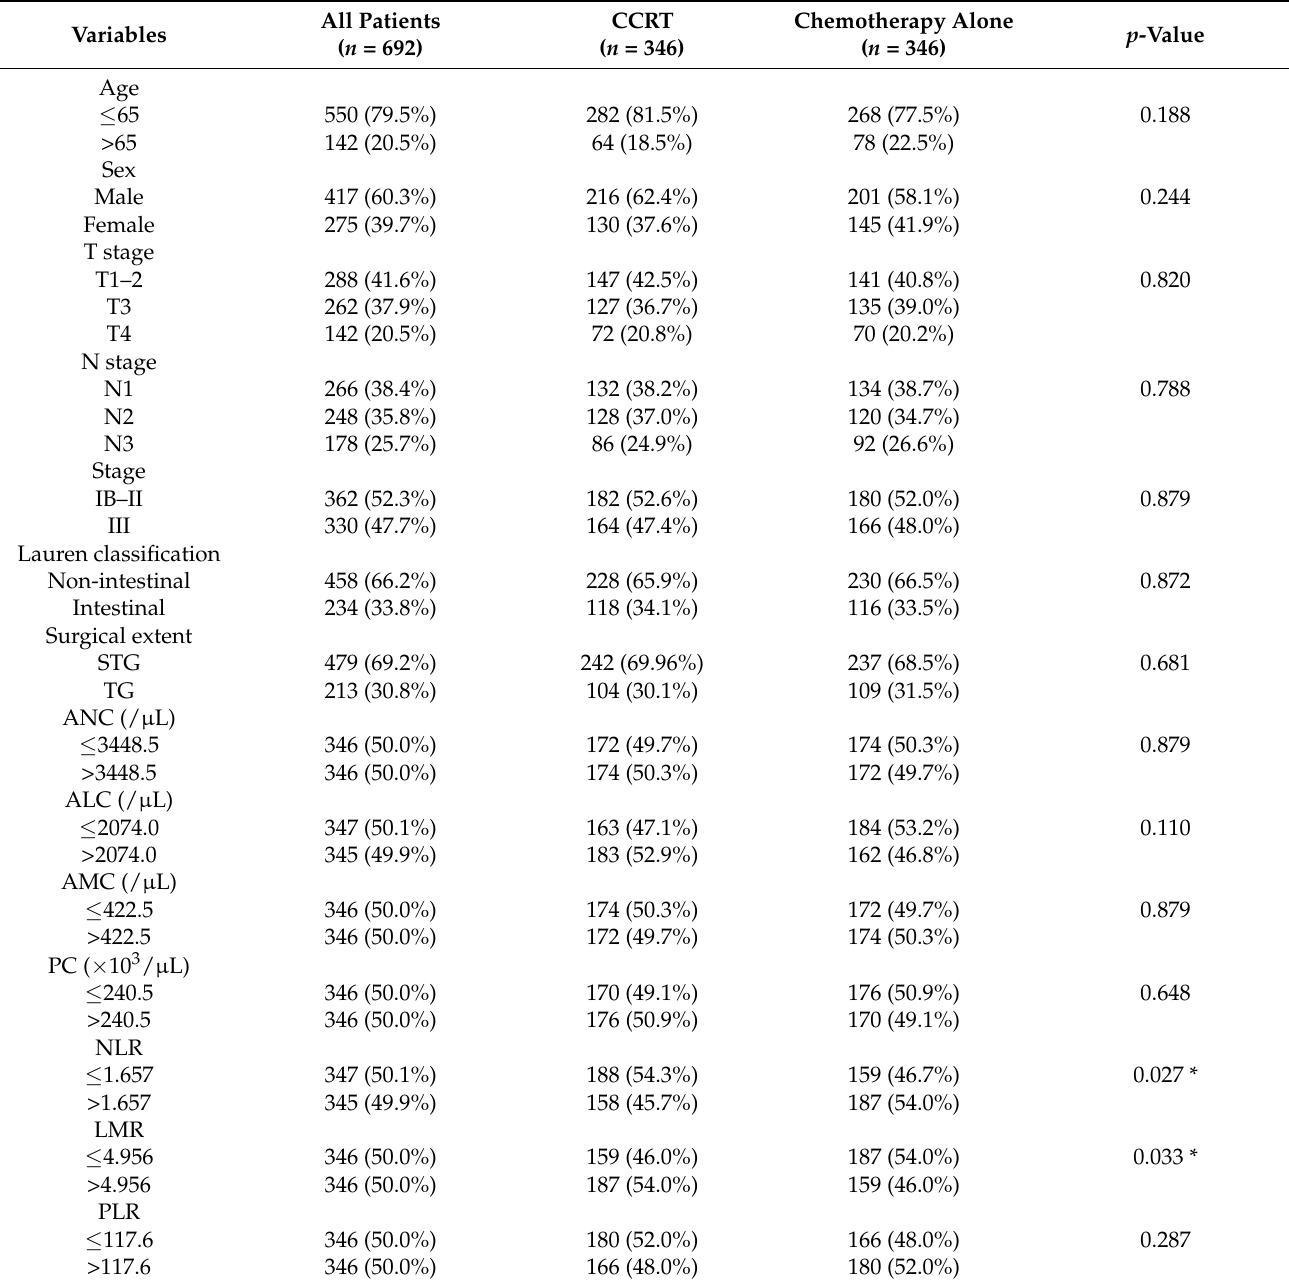
Table 1. Patients’